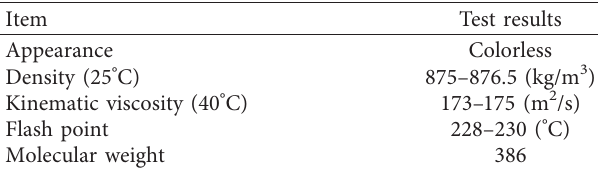
Table 2: Naphthenic oil index